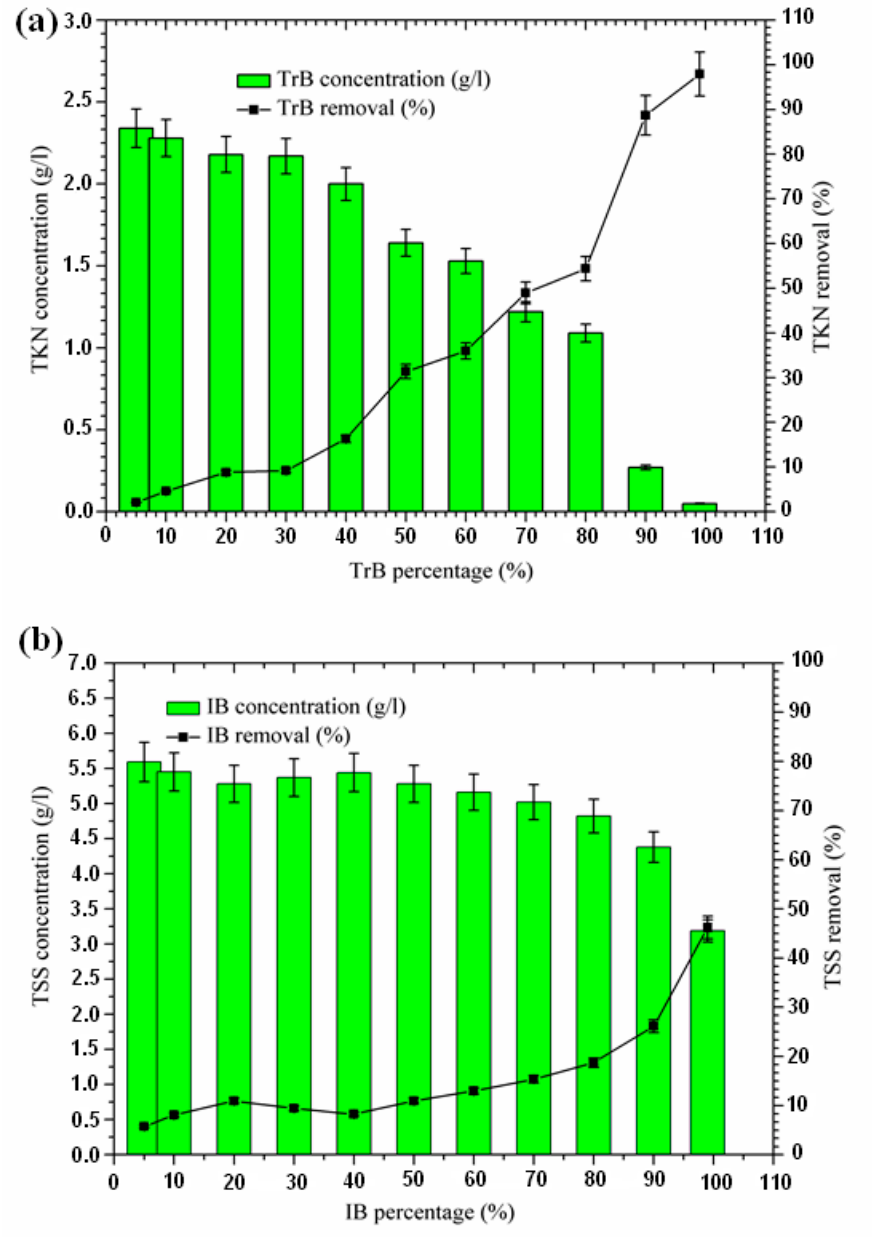
Figure 5. ( a ) Concentration and removal percentage of TSS by TrB; ( b ) concentration and removal percentage of TSS by IB.